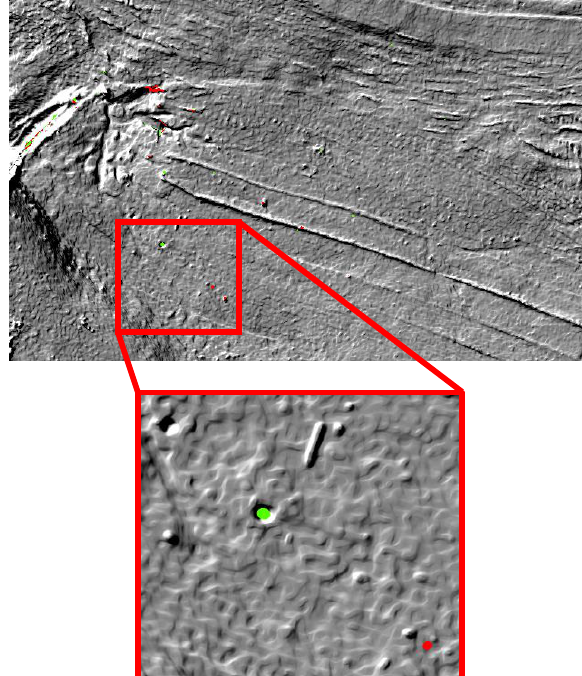
Figure 10. Identification of changes by the subtraction of DEMs after a global affine transformation: above 5 cm change (green), and below 5 cm change (red).